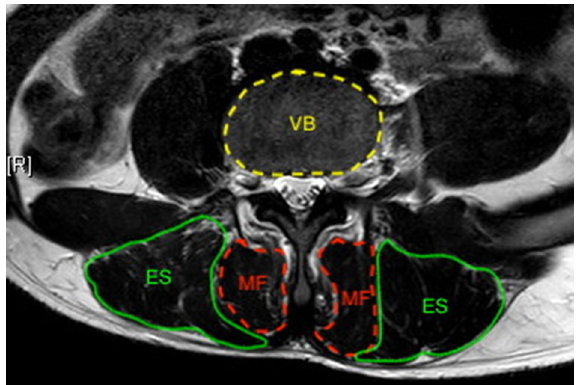
Figure 2. Measurement of cross-sectional area (CSA) of erector spinae (ES) and multifidus (MF) and L4 vertebral body using magnetic resonance imaging. CSA of muscle was calculated as the mean value of bilateral CSA. Muscularity = CSA of muscle − vertebral body ratio.